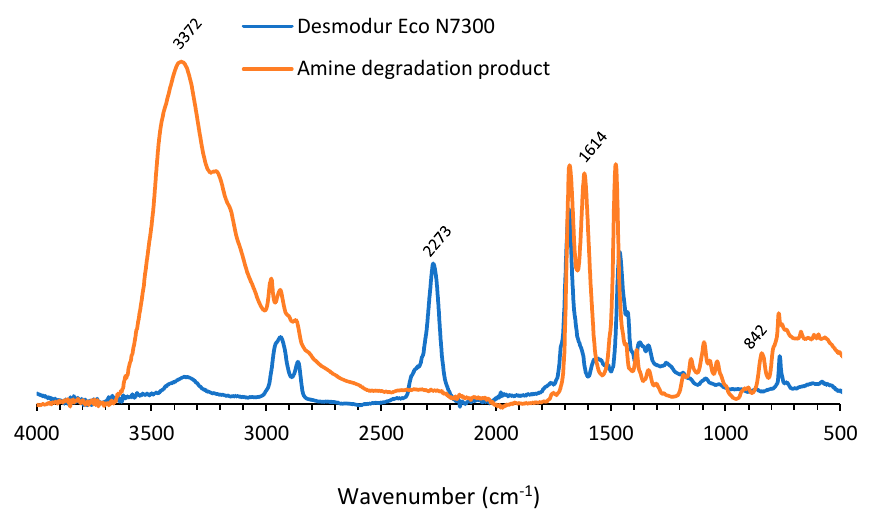
Figure 4. IR spectrum of amine degradation product and Desmodur eco N 7300.